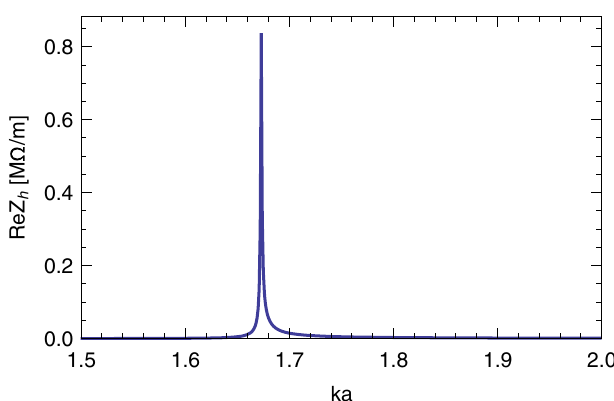
FIG. 3. The real part of the longitudinal impedance for the dechirper with plate width w → ∞ . This plot, in different units, and with the spike reaching to infinity, can also be found in Ref. [7].